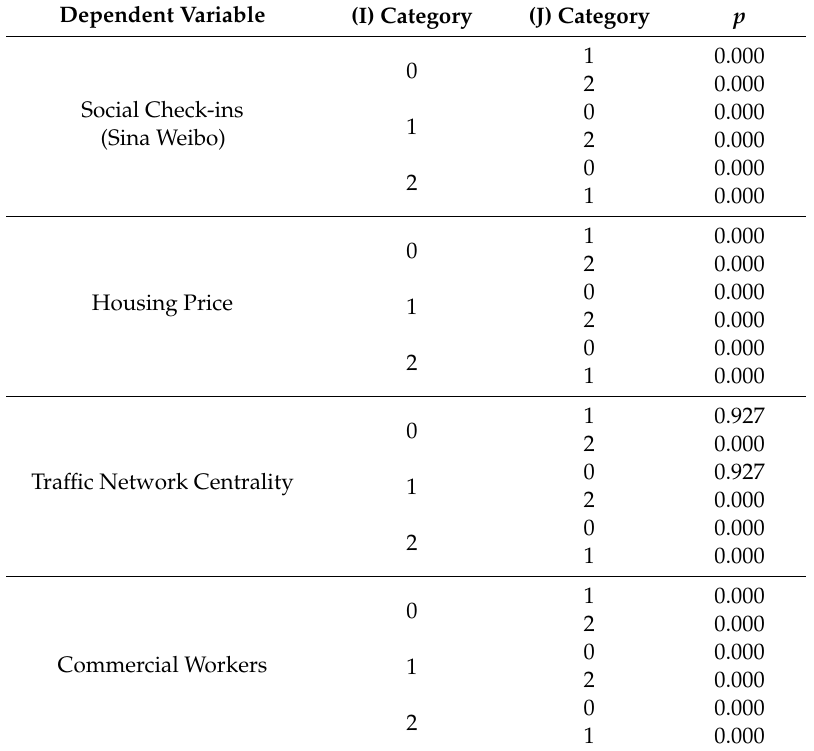
Table 2. Games-Howell test